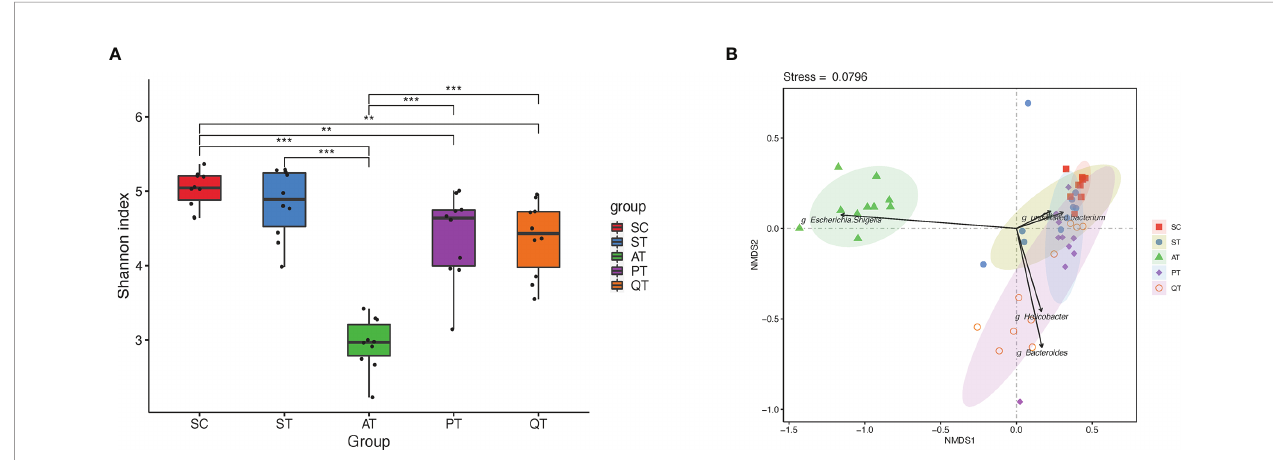
FIGURE 1 | Microbiota diversity and Non-metric multidimensional scaling (NMDS) distribution in fi ve groups. (A) The microbial diversity in the AT group was signi fi cantly lower than that in the PT and QT groups. (B) NMDS analysis, the gut microbiota samples from AT group showed an individual feature and separated far from that of the other groups, while the other groups shared partly with each other. **, and *** stand for the FDR-value <0.01, and <0.001,